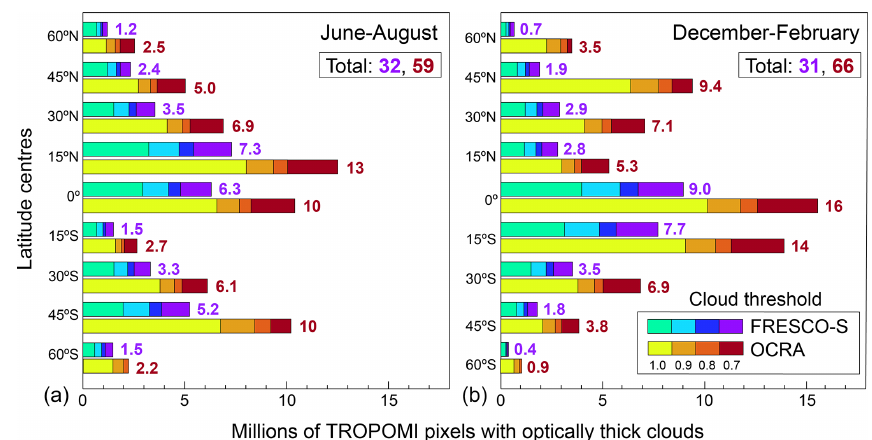
Figure 6. Meridional distribution of FRESCO-S and OCRA optically thick clouds in the upper troposphere. Bars count the occurrence of native TROPOMI pixels with cloud fractions ≥ 1 . 0, 0.9, 0.8, and 0.7 binned into 15 ◦ latitude bands in June–August (a) and December– February (b) for FRESCO-S (cool colours) where FRESCO-S cloud-top pressures are at 450–180hPa and OCRA (warm colours) where ROCINN-CAL cloud-top pressures are at 450–180hPa. Inset values are latitude band and global totals of TROPOMI pixels with cloud fraction ≥ 0 .